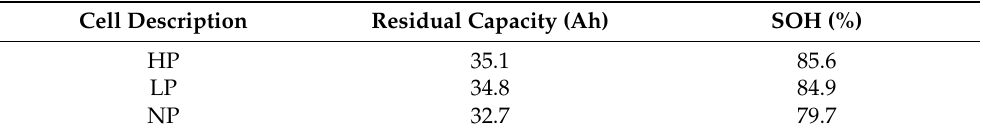
Table 4. Residual capacity and SOH after ageing.